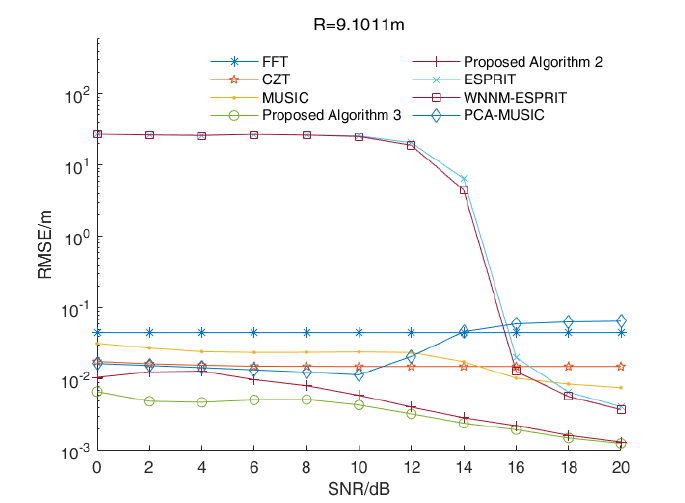
Figure 9. The RMSE values of the distance estimations versus the SNR values of various algorithms when R = 9.1011